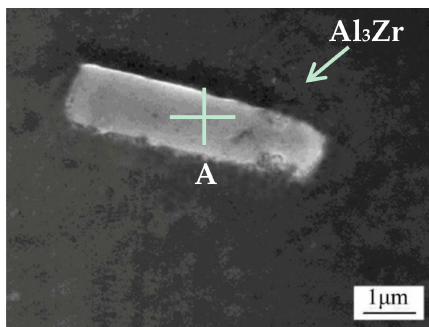
Figure 3. SEM image of the lath-like IMC (Intermetallic Compound) bearing